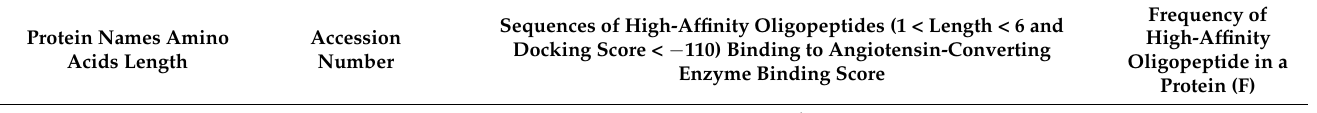
Protein Names Amino Acids